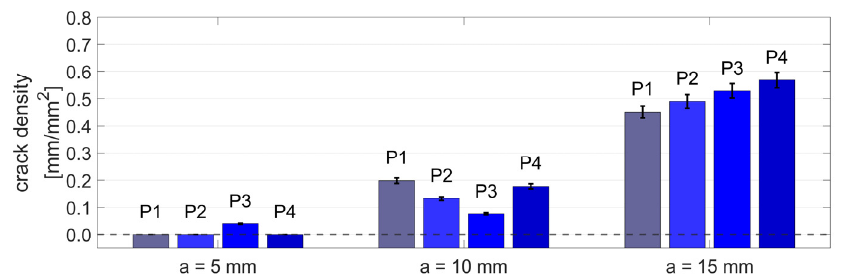
Figure 3. Crack density for specimens S1 to S12 with varied cube geometry and process parameter sets P1 to P4. The initial substrate temperature was constant around 20 °C. Error bars represent 5% measurement uncertainty.